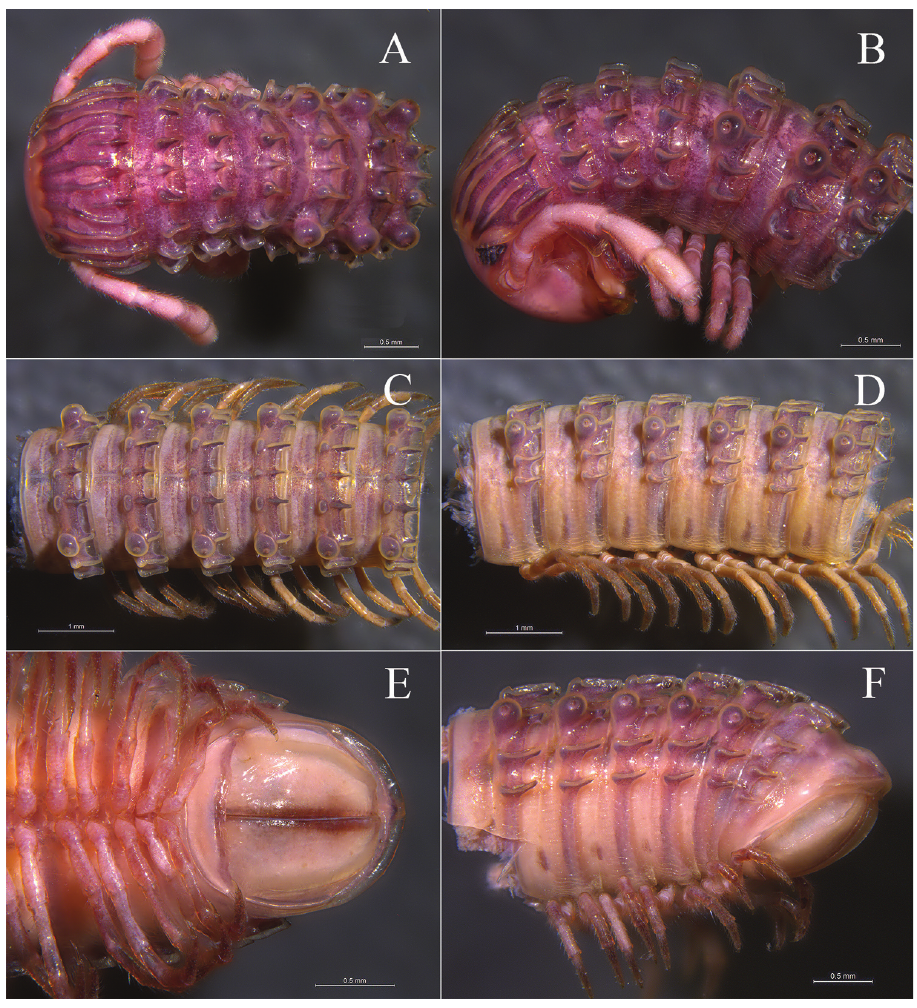
Figure 12. Glyphiulus guangnanensis sp. n., holotype. A anterior part of body, dorsal view B same, lateral view C midbody segments, dorsal view D same, lateral view E posterior part of body, ventral view F same, lateral